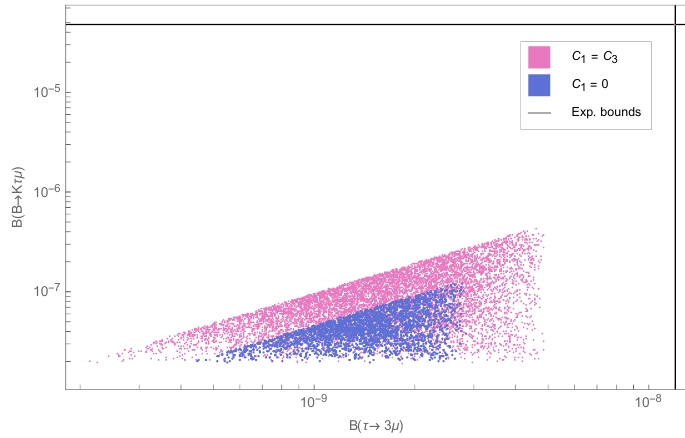
2 f(cid:0) 0 : 04 ; 0 : 04 g and (cid:3) = 1 TeV. 23